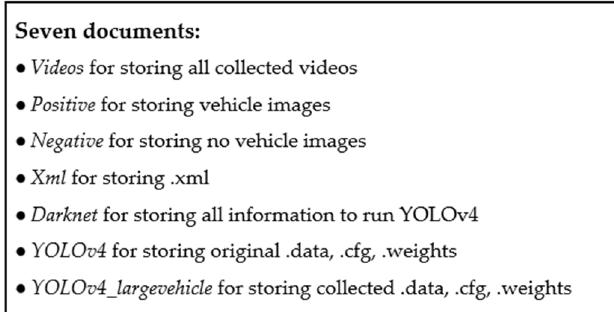
Figure 1. Data file description.